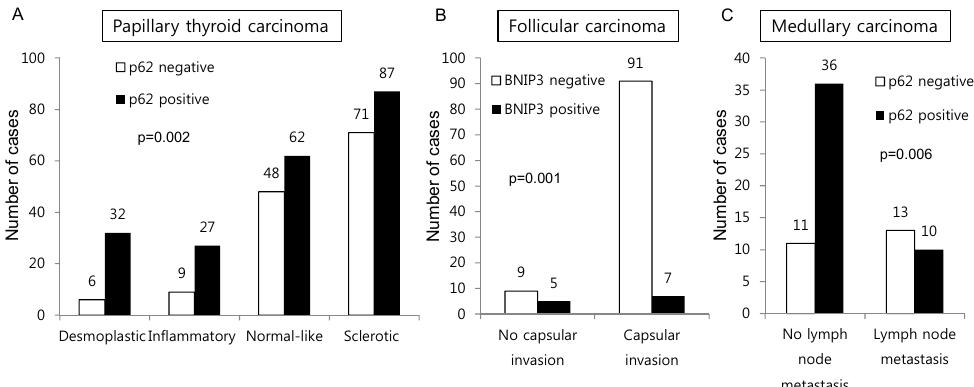
Figure 3. Correlations between clinicopathologic factors and autophagy-related protein expression in different types of thyroid cancer. In PTCs, p62 expression differed depending on the stromal type, whereas the proportion of tumors with positive p62 expression was higher among desmoplastic and inflammatory type tumors than among normal-like and sclerotic type tumors ( A ). BNIP-3 negativity was associated with capsular invasion in FC ( B ), and p62 negativity was associated with lymph node metastasis in MC ( C ).